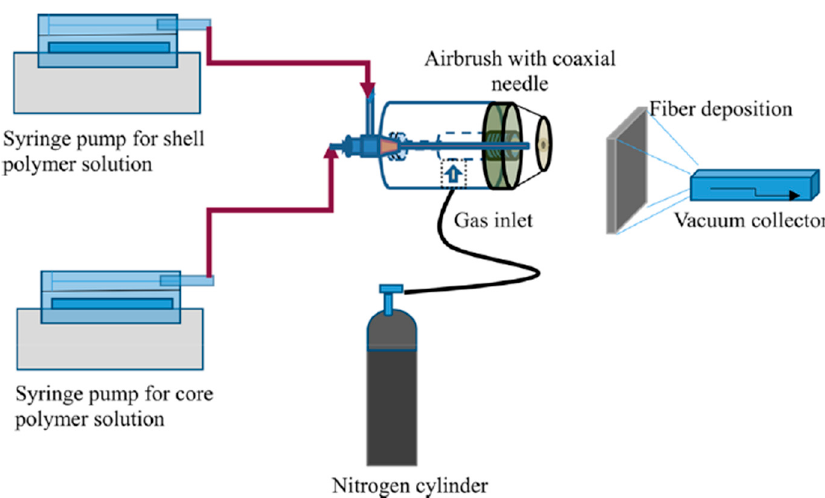
Figure 7. Schematic diagram of solution blowing spinning setup for single and core–shell structural